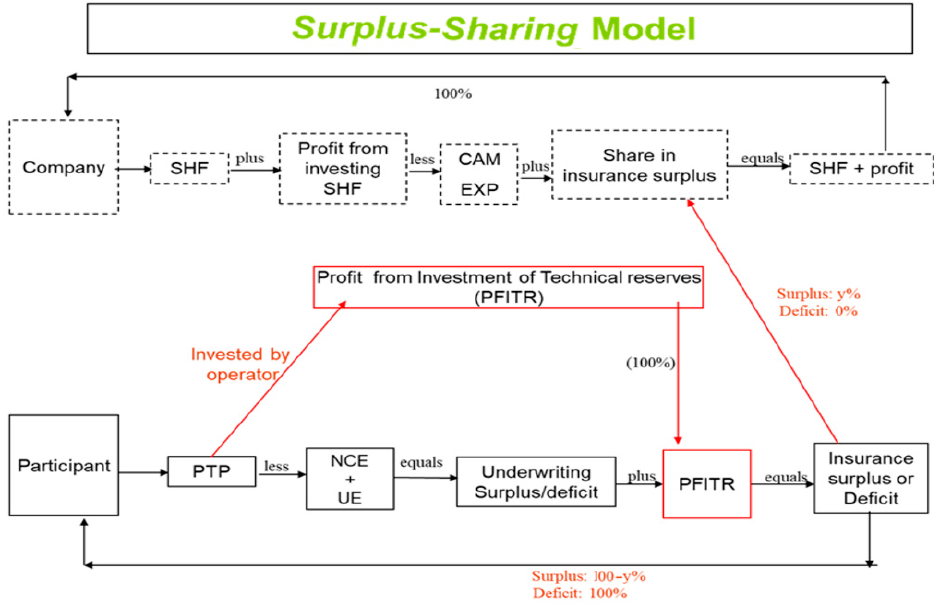
Figure 3. Performance-fee-based or surplus-sharing-based operational model of takaful.